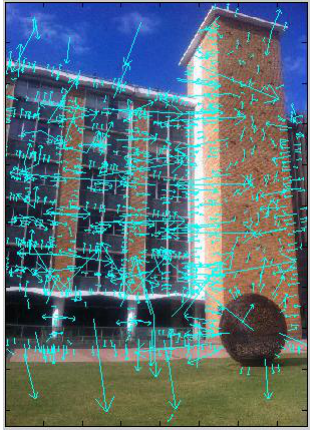
Figure 8. SIFT features extracted from the query image No. 3.